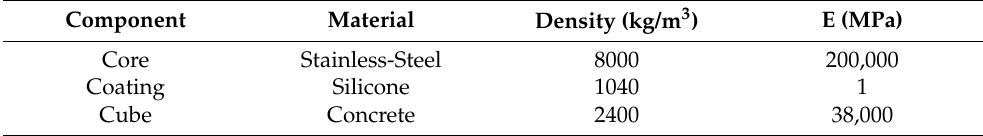
Table 1. Material properties used in the analysis.